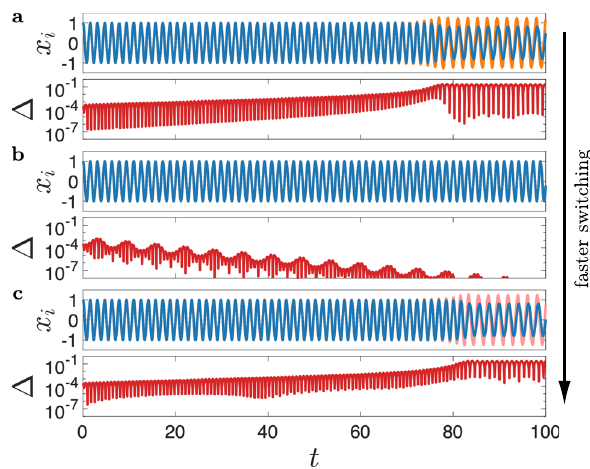
Fig. 4 Temporal networks that synchronize only for intermediate switching rate. Evolution of the oscillator states x i and the synchronization error Δ for a : ω = 0, b : ω = 1, and c : ω = 100. The oscillator parameters are the same as in Fig. 3 and the underlying temporal network is illustrated in Fig.